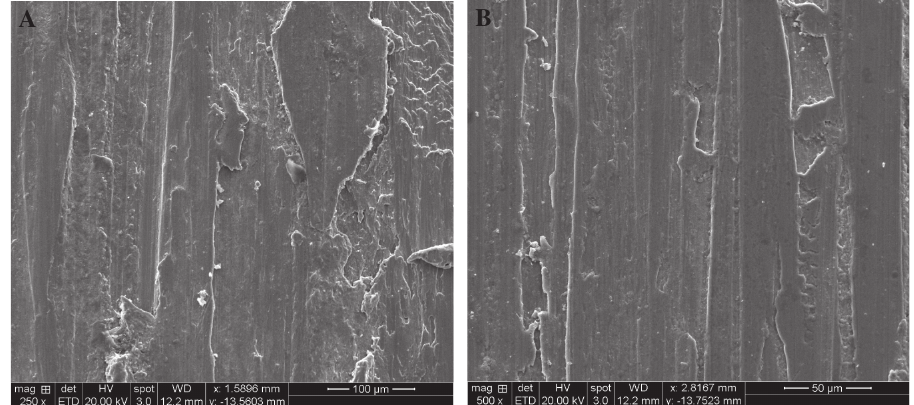
Figure 9 SEM of worn-out surface of MMC with 15%